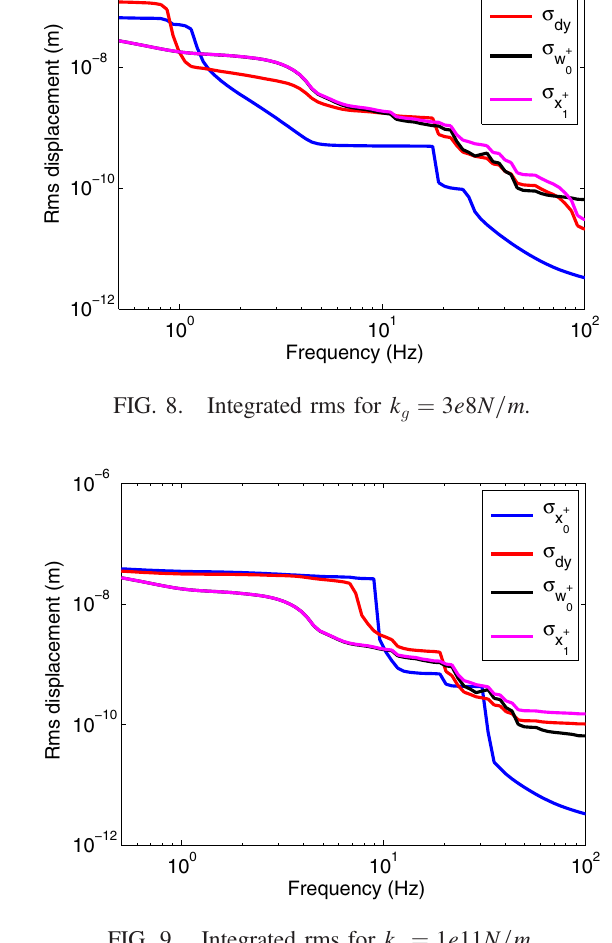
FIG. 9. Integrated rms for k